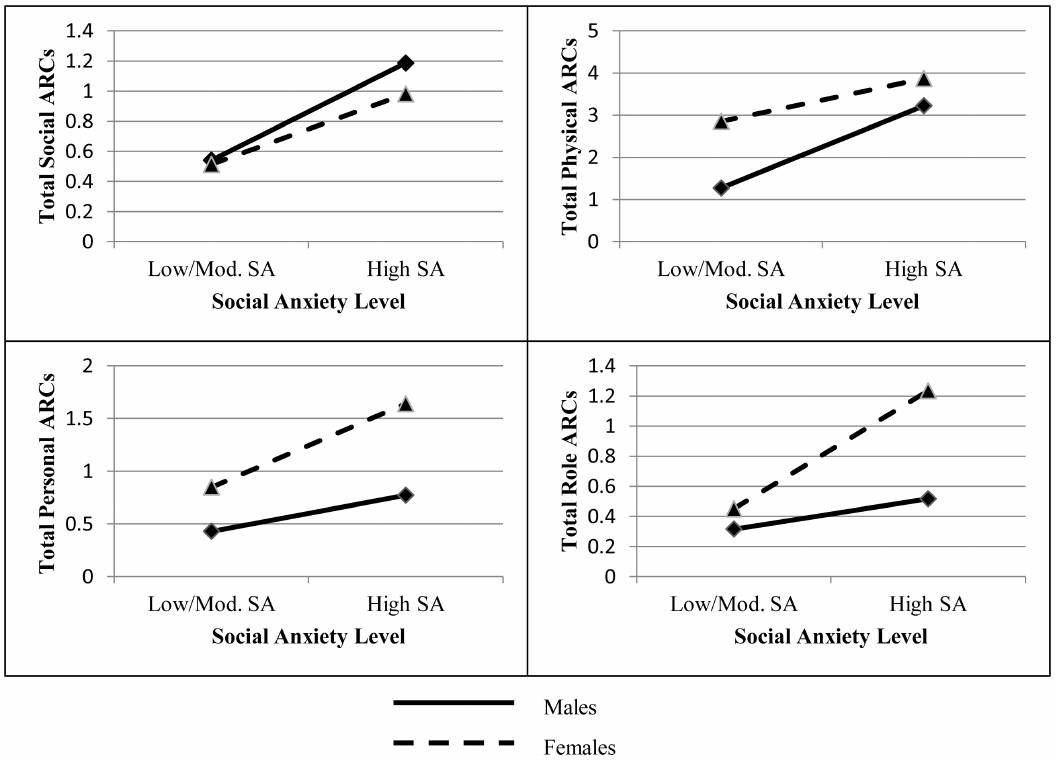
Fig. 1. Predicted Values for Each Type of Alcohol-related Consequences. Note: For estimation, quantity was held constant at the sample mean ( M 5